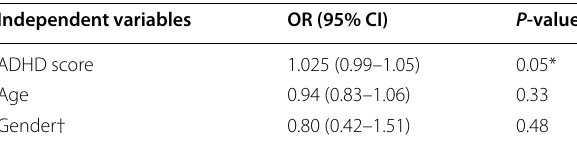
Table 3 Percentage of students fulfilling criteria for attention deficit hyperactivity disorder and central sensitization with and without back pain